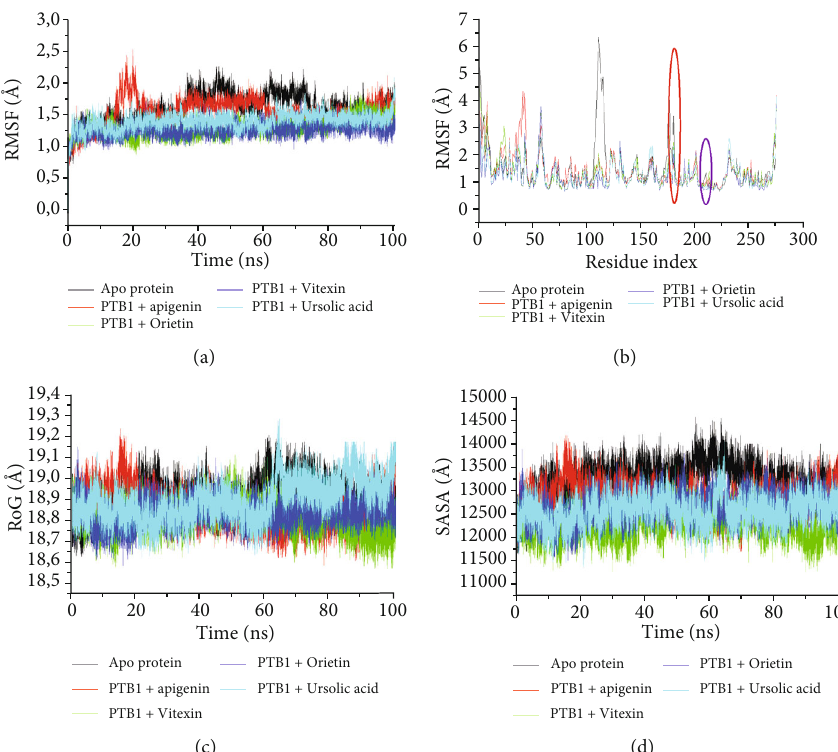
Figure 1: (a) Root mean square deviation (RMSD), (b) root mean square fl uctuations (RMSF), (c) radius of gyration (RoG), and (d) solvent accessible surface area (SASA) plots of comparison between protein tyrosine phosphatase 1B (PTP1B) and fl avonoid C-glycosides and ursolic acid determined over 100ns molecular dynamics simulations. PTB1: PTP1B (protein tyrosine phosphatase